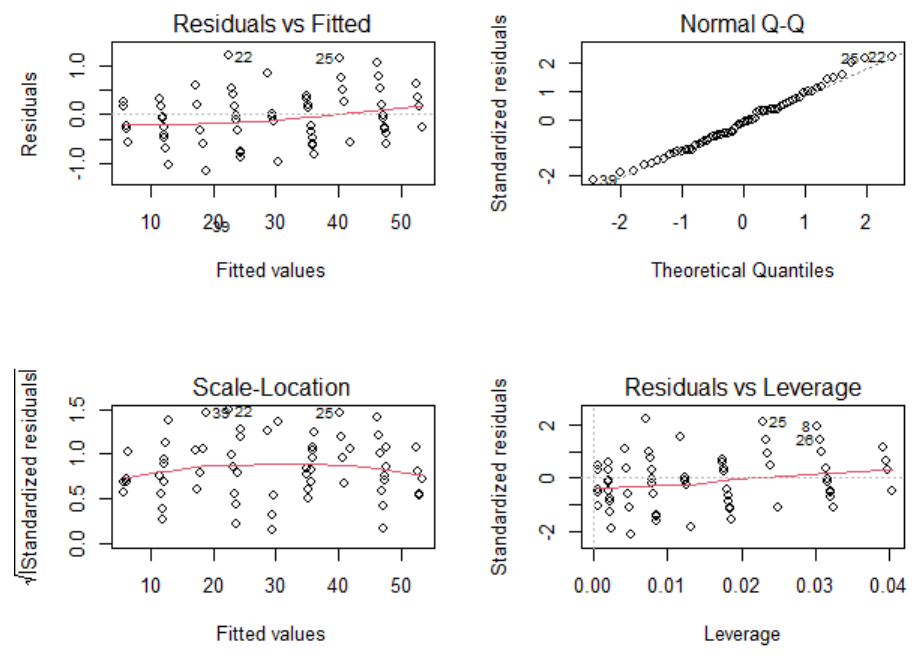
Figure 15. Residual plots generated from the linear regression model in Experiment 2. Applying paired t -test after correction, we found the results presented in Table 6. Findings indicated that there are no statistical difference in the average with a p -value much higher than